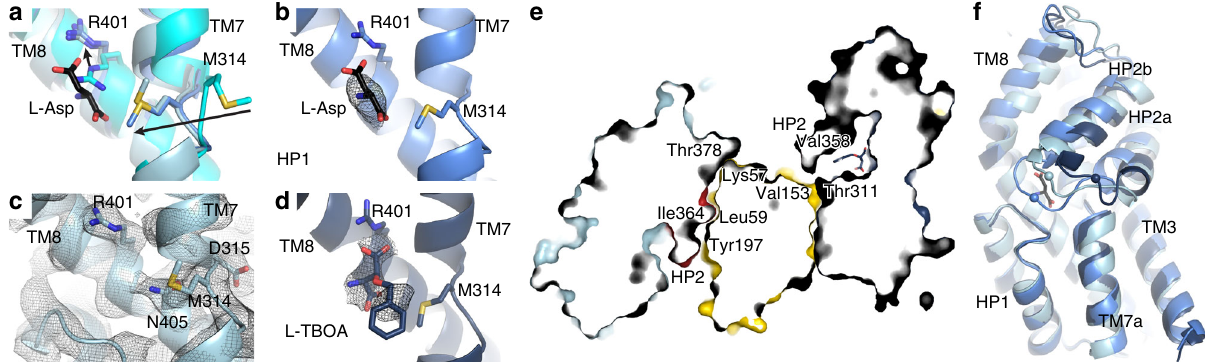
Fig. 2 Glt Tk substrate binding site and HP2 opening. a Overlay of apo (cyan), holo (Asp) (corn fl ower blue) and Na + -only states (light blue). The shift of Met314 and Arg401 is shown with arrows. b Cryo-EM density of L -aspartate (black mesh at 5 σ ). c Absence of the substrate in the inward open state (density is shown as gray mesh at 5 σ ). d Cryo-EM density of L-TBOA (black mesh at 4 σ ). e Slice through of TBOA-inhibited Glt Tk structure (surface representation) showing an inward-oriented and outward-oriented protomer. Opening of HP2 on both sides of the membrane prevents movements of the transport domains. f Superposition (on HP1) of the transport domains in inward Na + -only, intermediate-outward holo -Asp and fully-outward TBOA- inhibited (dark blue) states. Opening of HP2 in the inward state (4.4 Å) and TBOA-inhibited state (10.4 Å) in comparison with the occluded state is measured using C α of Val358 (shown as sphere). L -aspartate (black sticks) indicates position of the substrate-binding the multinomial distribution of the transport domains over all highest probabilities of occurrence under the substrate-unsaturated different possible states. The frequency of particles found with “ 2 conditions. It is possible that more states and a more complete in:1 out ” or “ 1 in:2 out ” arrangement (89% of all particles) indicates multinomial distribution could be resolved if many more particles that the inward-open and holo outward-intermediate states had the were collected.